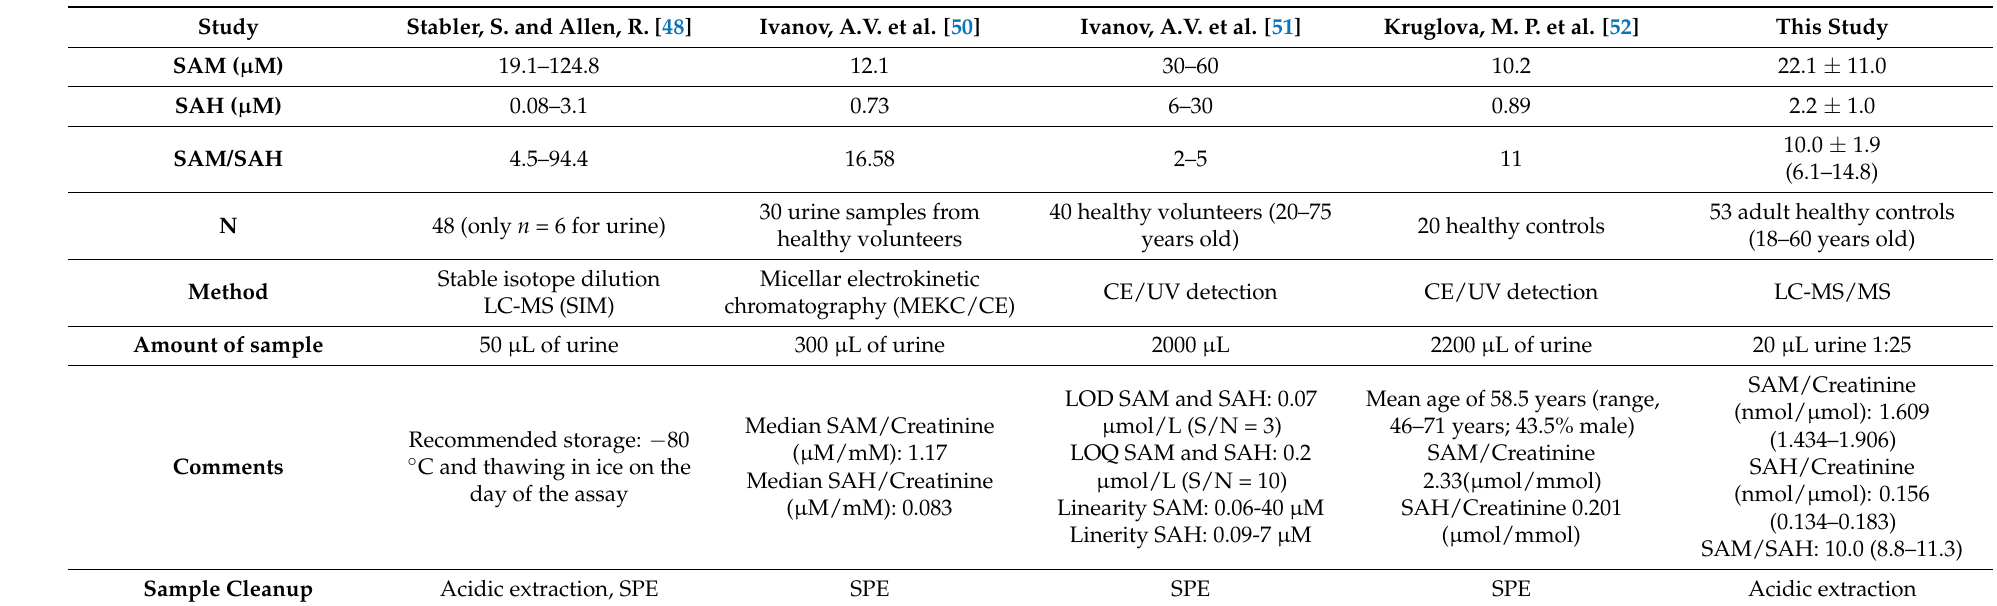
Table 5. Review of published SAM and SAH concentrations in human